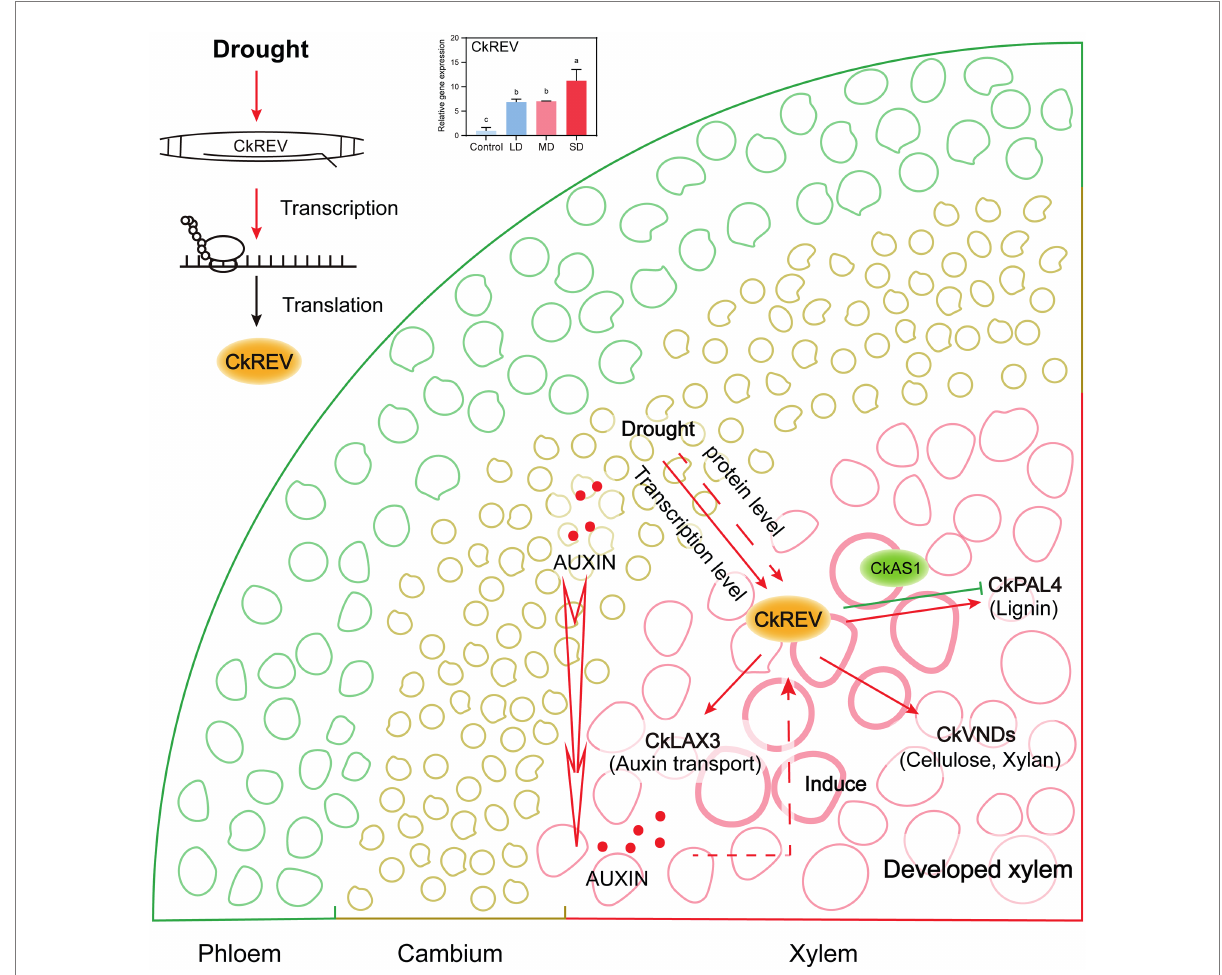
FIGURE 7 Model of CkREV regulating the secondary development of xylem vessels in response to drought. This model summarizes our results and shows that the expression level of CkREV located in xylem vessel and adjacent cells thereof will rise as the level of drought intensifies. CkREV senses drought stress signals, and regulates the expression of CkLAX3 , CkVND6 , CkVND7 , and CkPAL4 to control auxin polar transport, vessel differentiation, and synthesis of cell wall deposits, which is conducive to better plant growth under the condition of maintaining high drought